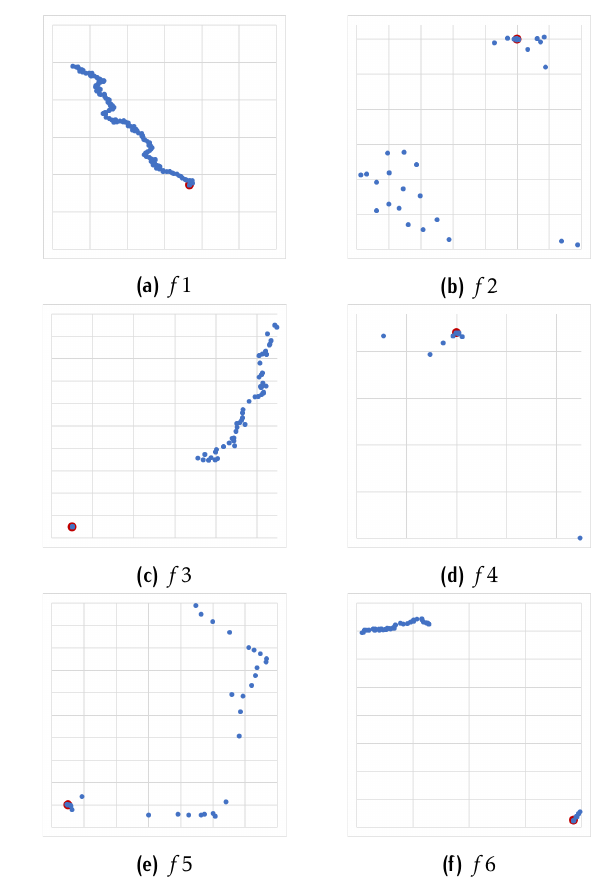
Figure 3. Trajectory of the best firefly with crossover with the best